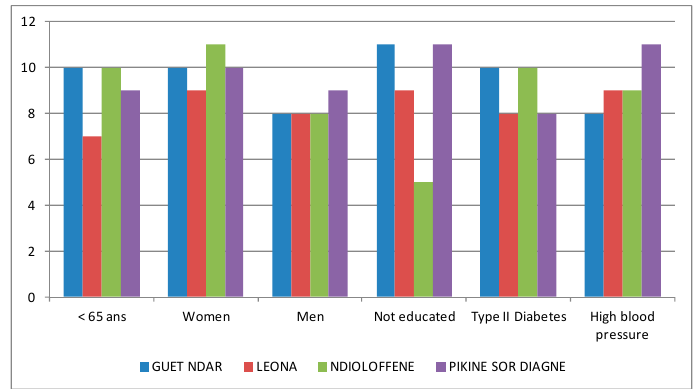
Figure 3. Characteristics of illness interview participants.